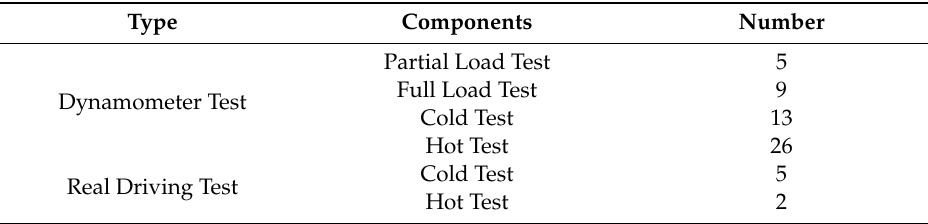
Table 2. Dynamo and Real Driving Test Data.